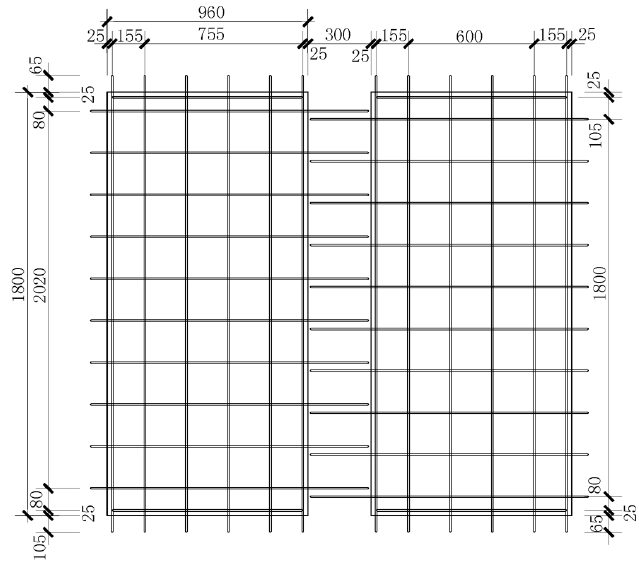
Buildings 2023 , 13 , x FOR PEER REVIEW Figure 2. The reinforcement diagram of the precast layer of the specimen. Figure 2. The reinforcement diagram of the precast layer of the specimen.